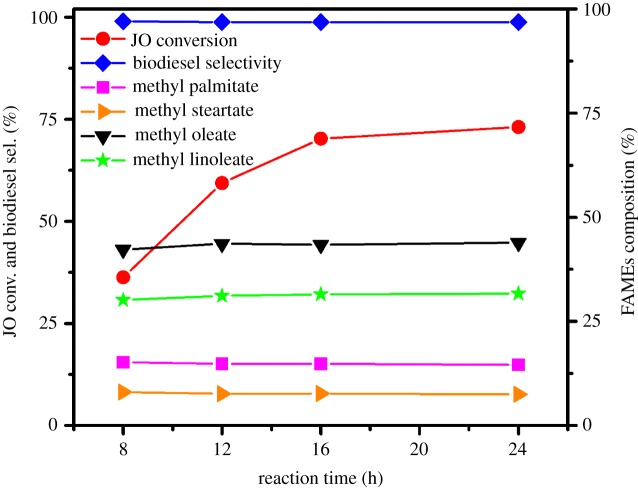
Effect of reaction time on transesterification of JO. Reaction conditions: JO 3.0 g, methanol 1.0 g, petroleum ether 1.0 g, 1.5SO42−/TiO2 catalyst 0.12 g, 393 K, stirring rate 600 r.p.m.